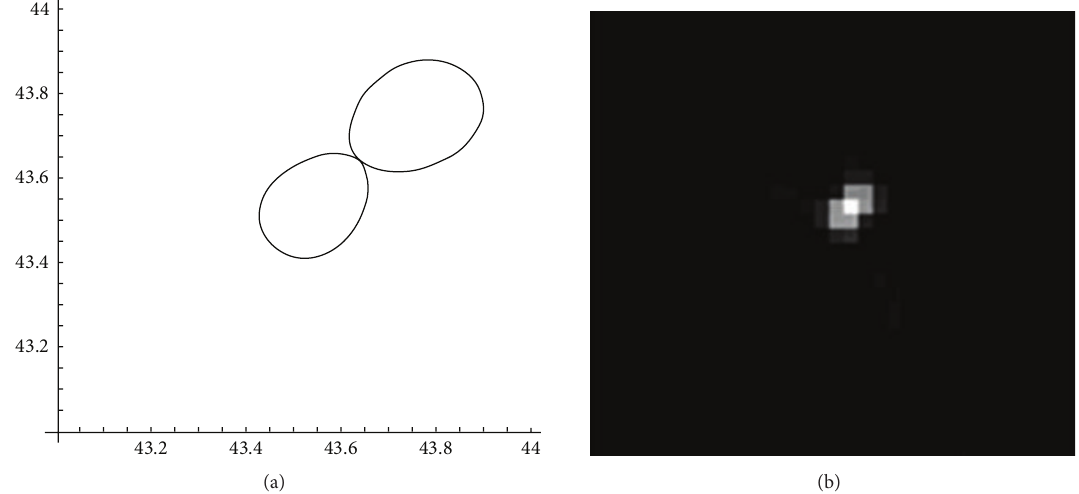
Figure 9: Analysis of artifacts caused by the deflection of linear detectors: (a) the trajectory of 𝑀(𝛽) ; (b) the reconstruction